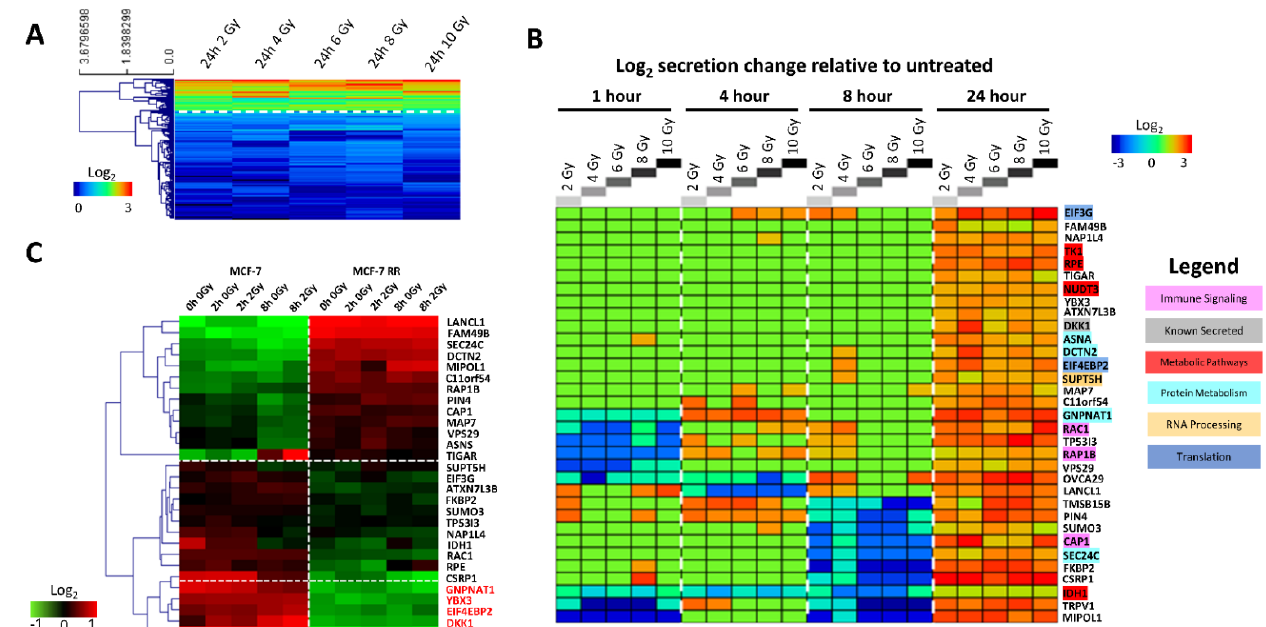
Figure 6. Candidate biomarker selection. ( A ) Protein secretion heatmap showing the log 2 secretion level of all 159 proteins identified from the radiation-induced secretome across all doses of radiation (2, 4, 6, 8 and 10 Gy) at 24 h. Cluster analysis, performed using Pearson correlation with average linkage, gave rise to two clusters. The upper cluster was found to contain 33 proteins with significantly higher levels of secretion in response to radiation across all doses at 24 h. Heatmap colours indicate log 2 secretion level as denoted by the colour bar. ( B ) Protein secretion heatmap showing the log 2 secretion level changes of the 33 proteins from the upper cluster in Figure 3A across all timepoints and radiation doses, normalised to untreated controls at each timepoint. Heatmap colours indicate log 2 secretion level changes compared to untreated controls at each timepoint as denoted by the colour bar (red = higher expression, green = no change, blue = lower expression). Proteins belonging to pathways found to be enriched in the radiation-induced secretome are highlighted according to the legend. ( C ) Heatmap of log 2 mean-centred gene expression data from both untreated controls and radiation treated MCF-7 and MCF-7 RR cells, comparing the expression levels of the 33 secreted proteins at the gene level. Clustering was performed using Pearson correlation with average linkage (red = higher expression, black = no change, green = lower expression).